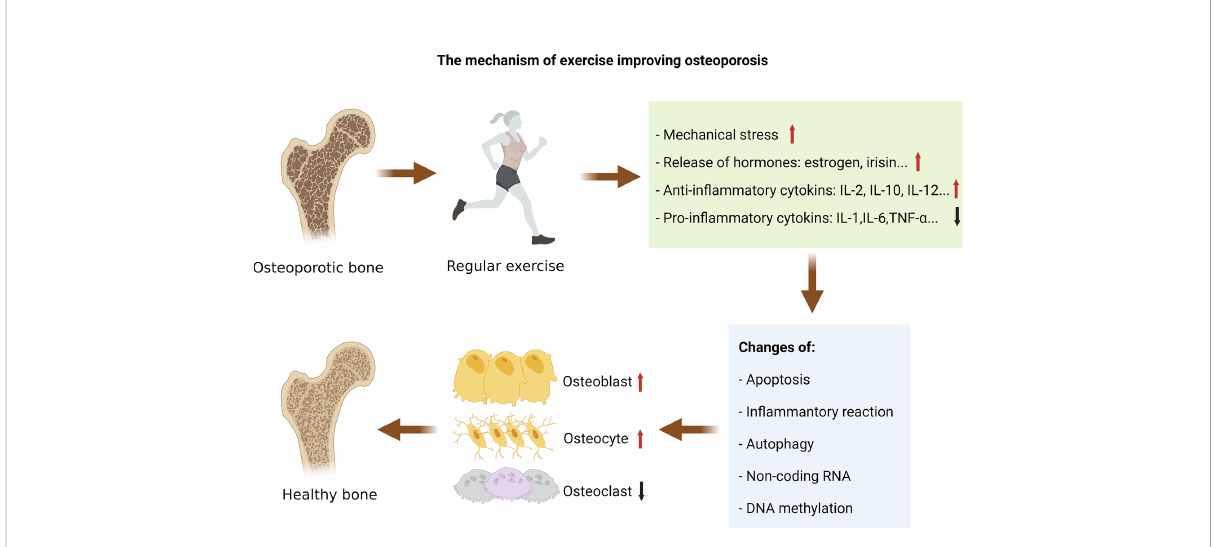
FIGURE 2 The mechanism of exercise improving osteoporosis. Exercise-induced changes in mechanical stress, hormones, and cytokines can regulate the pathological changes of osteoporosis. Mechanistically, exercise reduces the harmful osteoporosis alterations via affecting